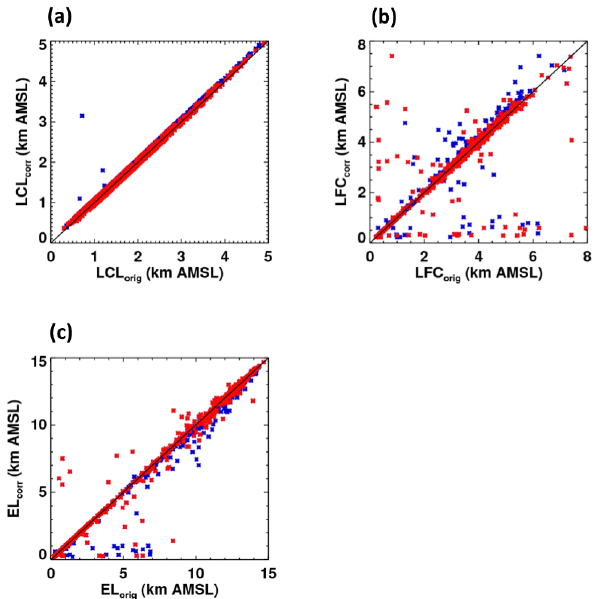
Figure 8. Scatterplots of convective levels comparing original (orig) and humidity-corrected (corr) soundings for (a) LCL, (b) LFC and (c) EL. Daytime soundings (12:00–24:00UTC) are indicated with red markers while nighttime soundings are blue. Convective levels are computed using the level of maximum virtual temperature in the lowest kilometer above ground level of the sounding.